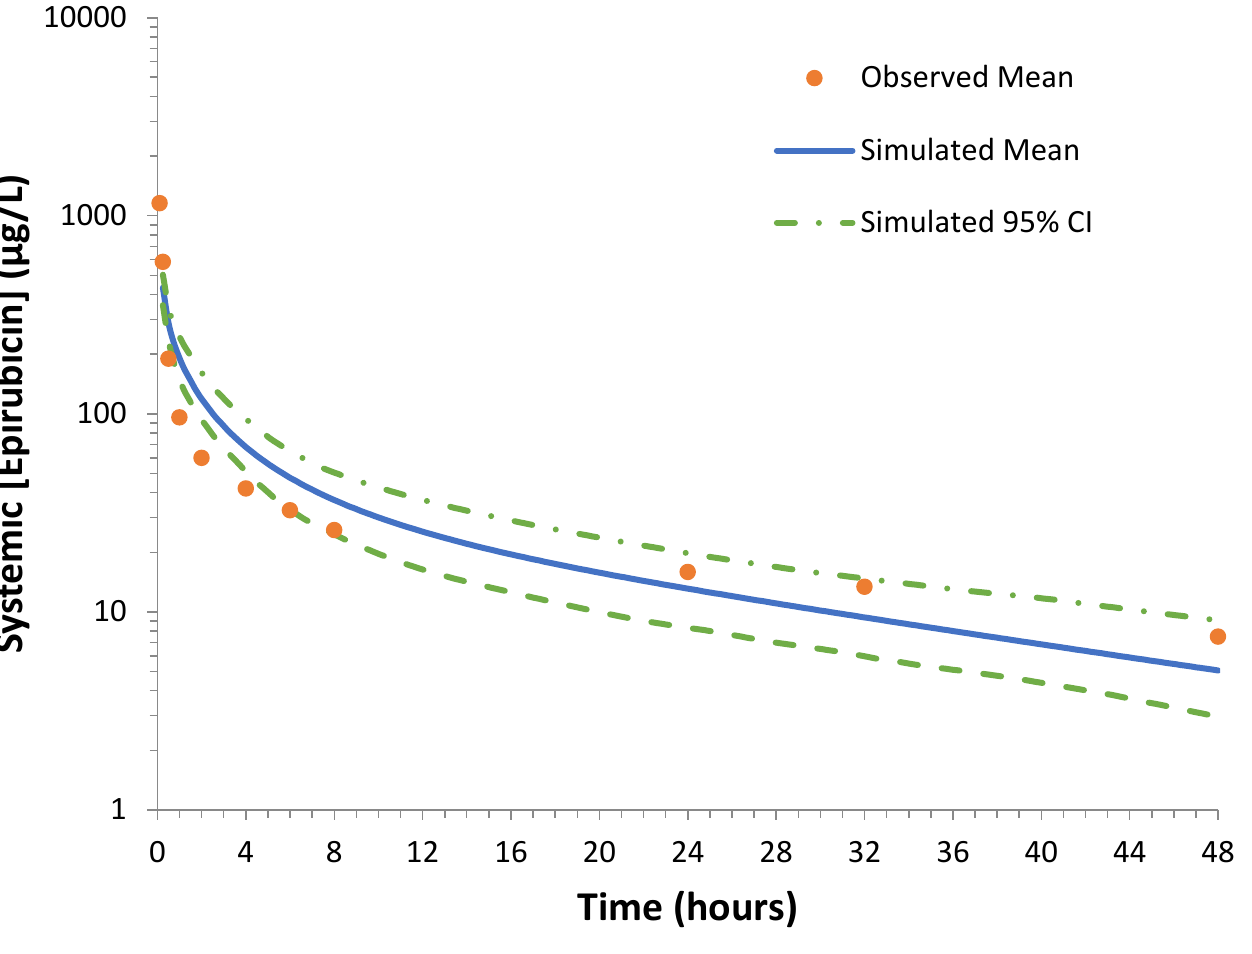
Table 3. Marked variability in epirubicin AUC and C max was observed; by way of example, AUC values ranged from 2980 to 12,710 ng/mL · h (mean 5374 ng/mL · h). Simulated epirubicin AUC and C max values, and the variability in these parameters, were consistent with observed exposure profiles